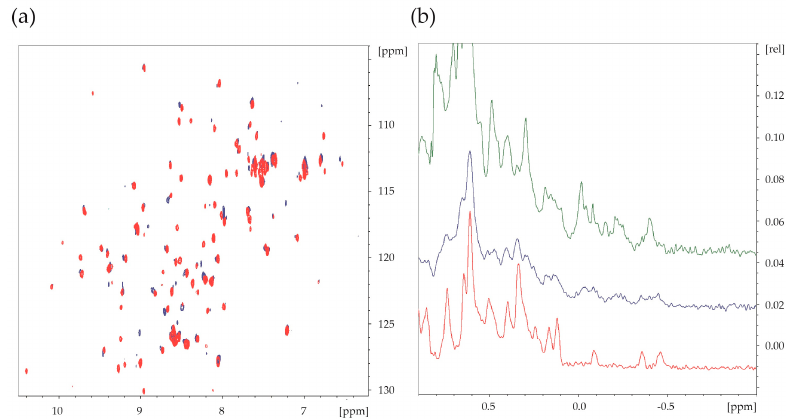
Int. J. Mol. Sci. 2018 , 19 , x